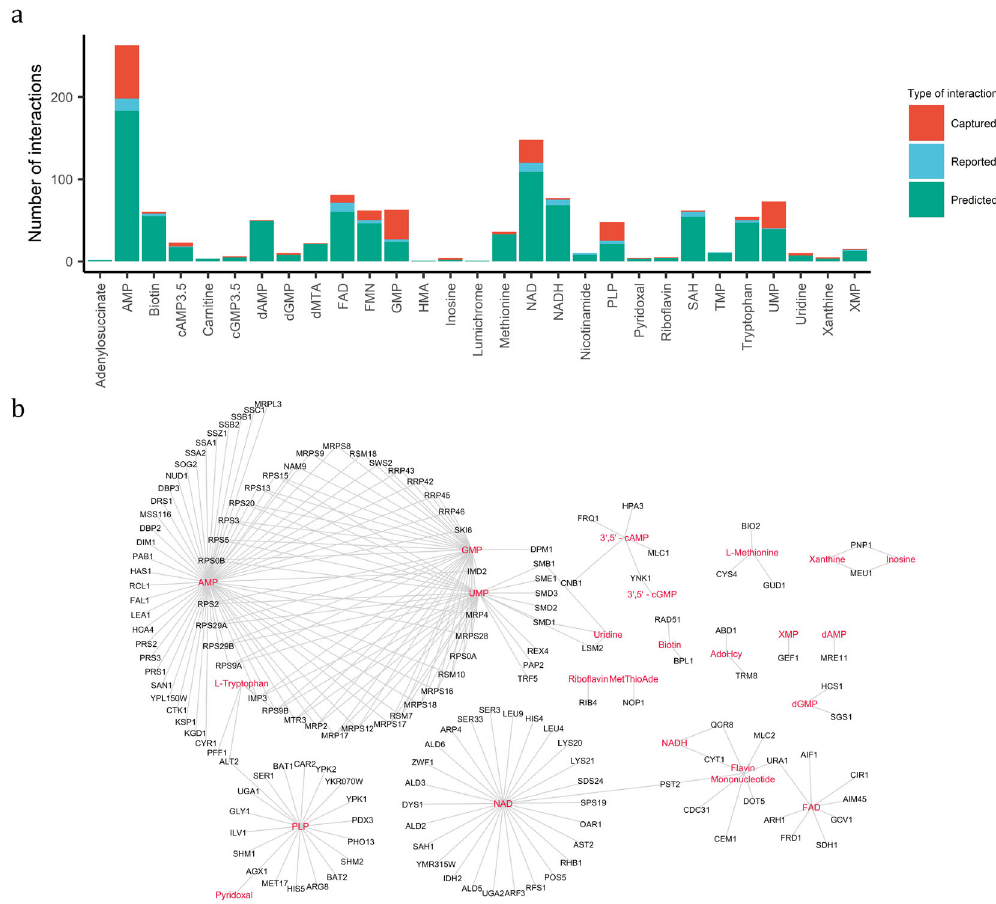
Fig. 2 PROMIS provides experimental validation for multiple predicted protein – small molecule complexes. a Number of captured protein – small molecules interaction in relation to previously reported and predicted interactions for each metabolite validated by our data set (Supplementary Data S9 and S11). b The interaction network of 225 STITCH predicted protein – small molecule interactions validated in this study (Supplementary Data S11). Edges represent protein – small molecule interactions and were imported from STITCH, based on the experimental evidence (score ≥ 0.4). Proteins and metabolites are marked as black and red, respectively. Metabolite abbreviations: AdoHcy adenosyl homocysteine, AMP adenosine monophosphate, dMTA/MetThioAde methylthioadenosine, HMA hydroxy methylglutaric acid, PLP pyridoxal phosphate, SAH S-adenosyl-homocysteine, TMP thymidine monophosphate, UMP uridine monophosphate, XMP xanthine